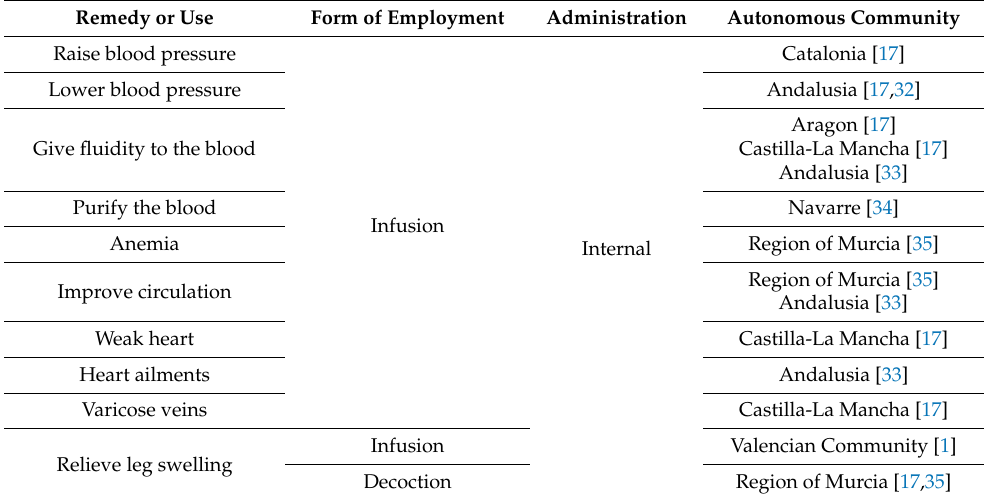
Table 1. Compilation of the medicinal uses of Chiliadenus glutinosus as a remedy for diseases of the circulatory system in Spain, compiled from the existing specific literature. Remedy or